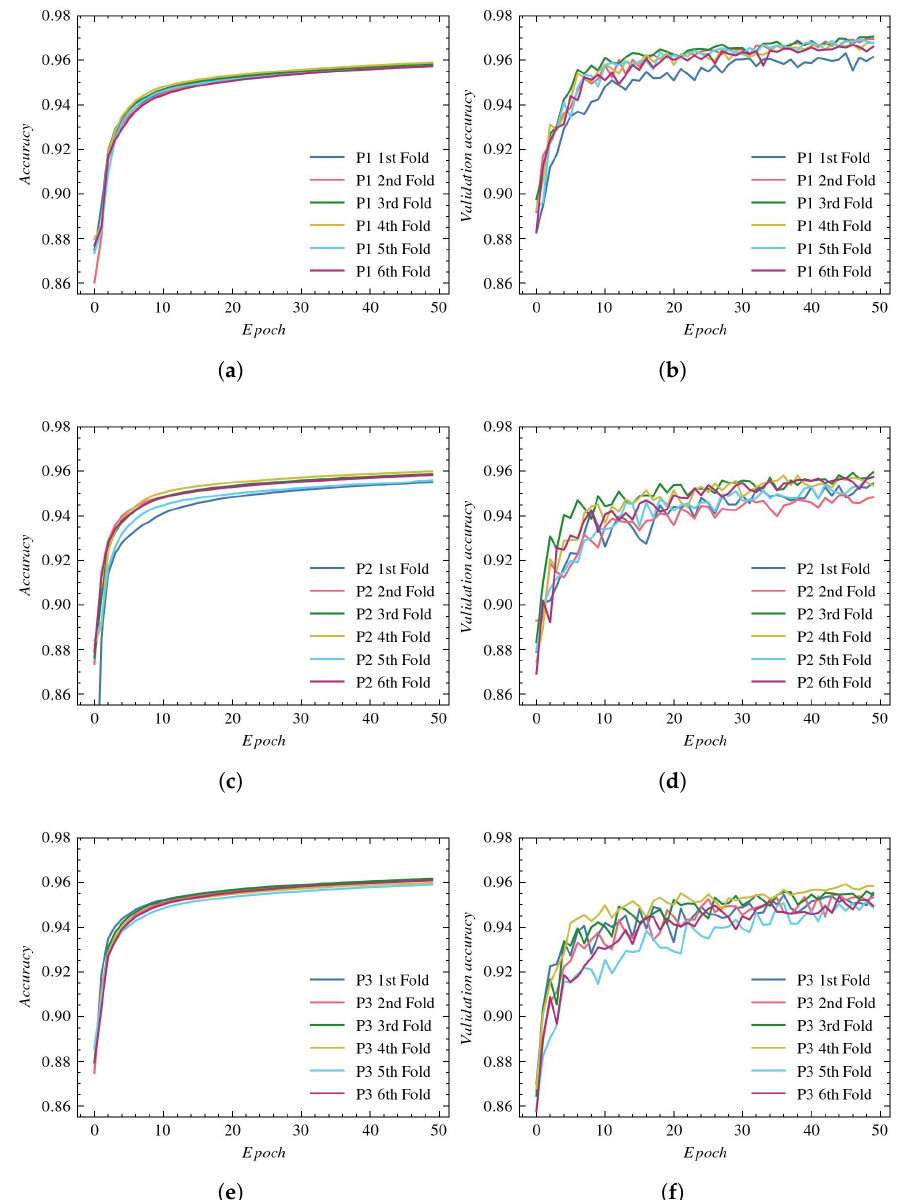
Figure 7. Accuracy plots for UNet architecture: ( a ) training using P1, ( b ) validation using P1, ( c ) training using P2, ( d ) validation using P2, ( e ) training using P3, and ( f ) validation using P3. The training accuracy in all experiments reaches values equal to approximately